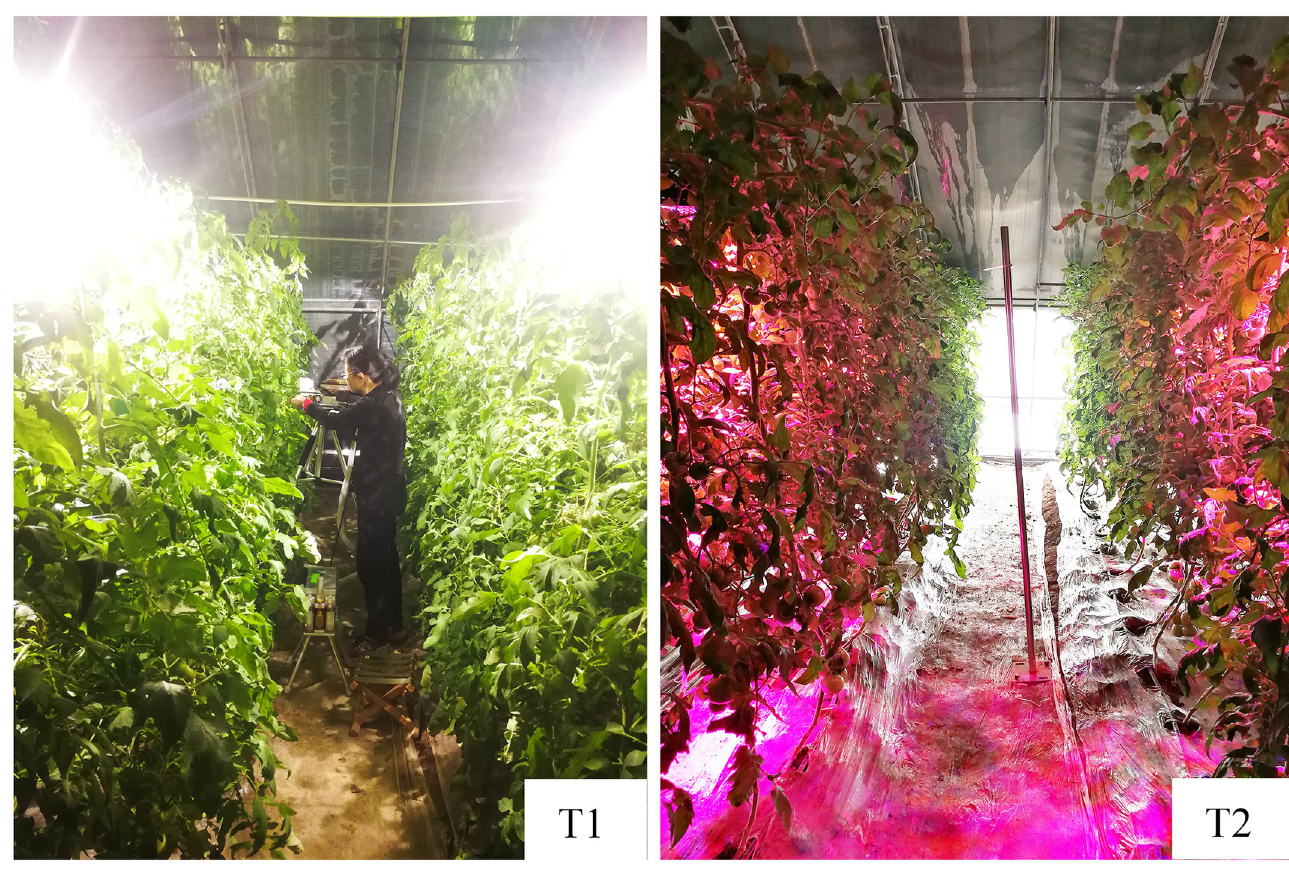
Fig 2. Treatments with supplemental light. (T1, HPS; T2, LED).